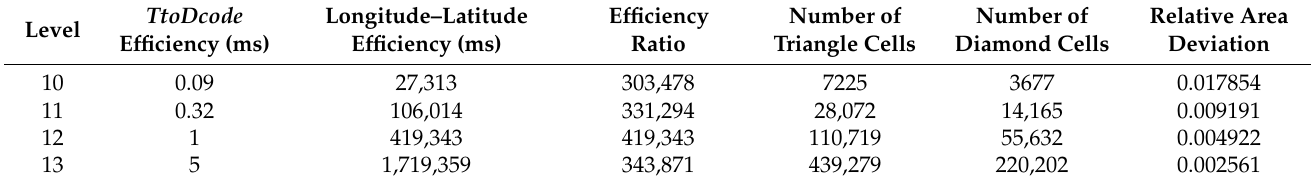
Table 21. Comparison of efficiency and accuracy of TtoDcode and longitude–latitude expressing discrete